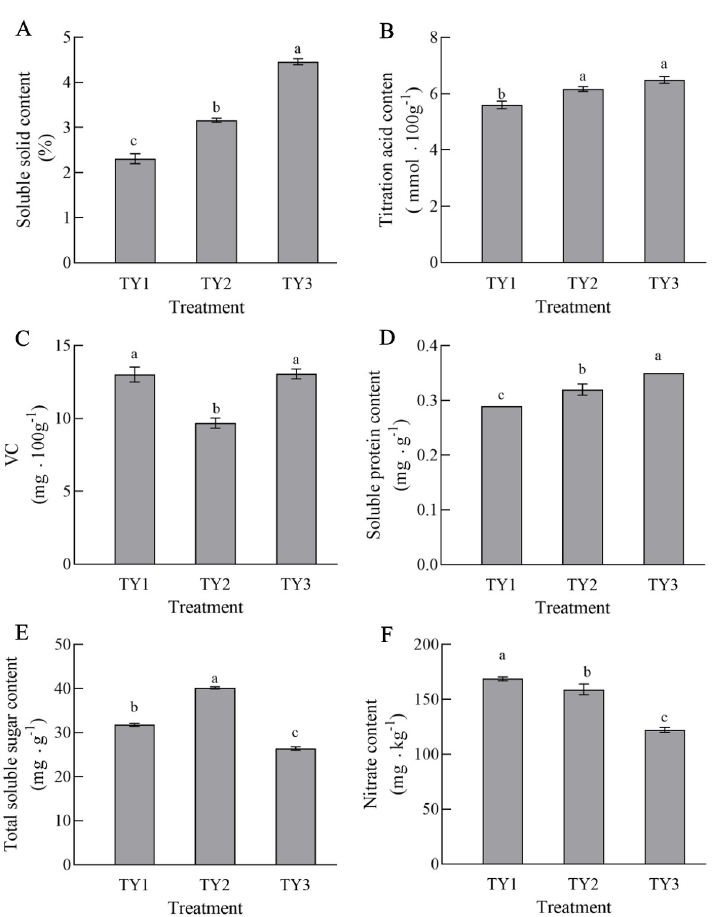
Fig 7. Comparison of tomato quality among different planting patterns. (a) soluble solids, (b) titration acid, (c) VC content, (d) soluble protein, (e) total soluble sugar, (f) nitrate content. Different lowercase letters in the same column indicate significant differences at 0.05 level. For each planting method group, bar charts labelled by different letters are significantly different according to one-way analysis of variance (ANOVA) (P < 0.05) and Duncan’s Multiple Range Test (DMRT) (P < 0.05). TY1, Tomato continuous cropping; TY2, Eggplant-tomato rotation; TY3, Arrowhead-tomato